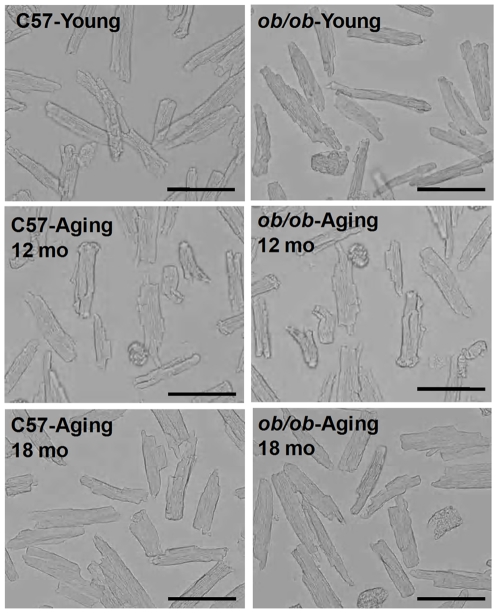
Light microscopic images of cardiomyocytes freshly isolated from
young (4-month-old) and aging (12- or 18-month-old) lean (C57) and
ob/ob mice.200x, scale bar  = 100 µm.